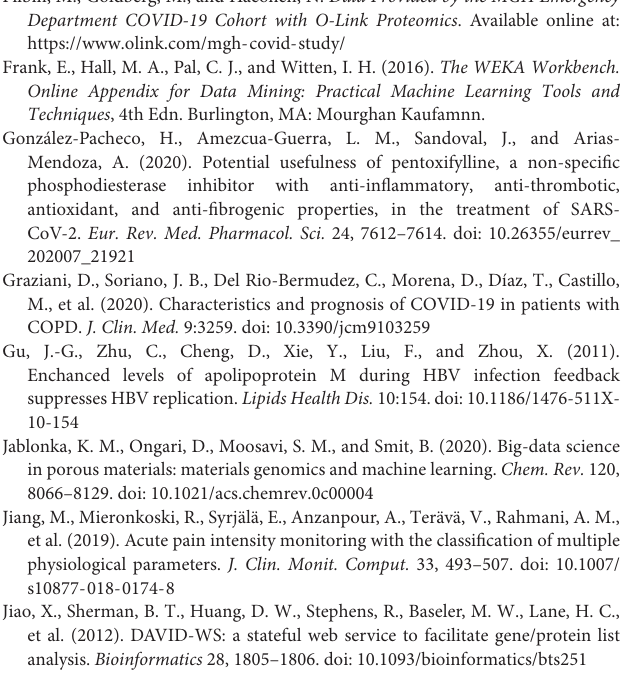
Supplementary Table 3 | NPX expression values for 45 shortlisted proteins. Supplementary Table 4 | Drug–target interactions retrieved from